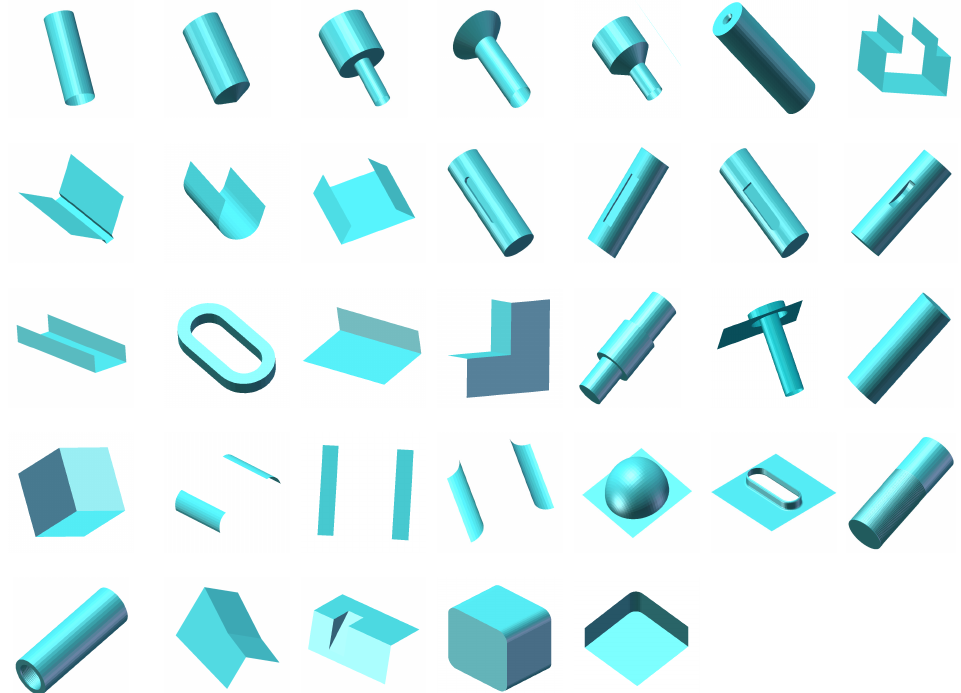
Figure A2. The machining feature surface point extraction results of